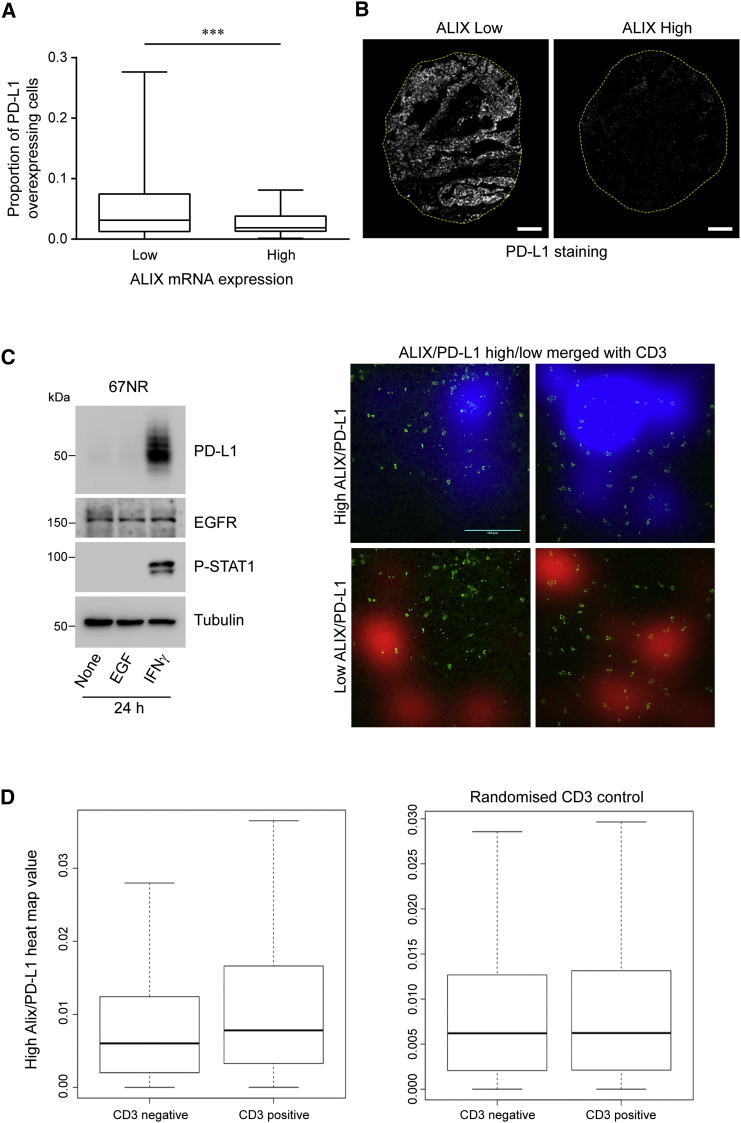
In Vivo Relationship between ALIX and PD-L1 Expression and Its Association with Immune Cell Infiltrate(A) Boxplot of PD-L1 protein expression according to “low” (n = 95) or “high” (n = 94) ALIX mRNA expression, where “low” and “high” indicate less than and greater than the median value, respectively (∗∗∗p < 0.001, Mann-Whitney U, two-tailed test).(B) Fluorescence images of PD-L1 immunostaining of representative breast cancer tissue specimens associated with low (left) and high (right) ALIX mRNA expression (dotted line indicates the perimeter of tissue specimen). Scale bars, 100 μm.(C) Western blot showing IFNγ-dependent induction of PD-L1 in 67NR cells. Spatial analysis of ALIX, PD-L1, and CD3 expression in tissue sections processed for analysis by immunofluorescence. Comparison of CD3+ cell position with heatmaps of high and low ALIX:PD-L1 expression ratios in 67NR tumors. Representative composite images of CD3 channel (green) with ALIX:PD-L1 ratio heatmaps (red and blue). Heatmaps were generated by applying a 2D Gaussian image blur to a thresholded ALIX:PD-L1 ratio image. Ratio images were thresholded for pixel regions (>1 pixel) where the ratio > 2.0 (high ratio) or < 0.5 (low ratio) after ALIX intensity values were normalized to achieve a baseline ratio of 1.0. Pixels where the ALIX:PD-L1 ratio was <0.5 (low ratio) are more excluded for CD3+ T cell infiltration. Scale bar, 100 μm.(D) Quantification of data from (C). Left panel: in 67NR tumors, the presence of CD3 correlates with a higher heatmap value (CD3+ mean = 0.0115, SEM = 0.0002; CD3− mean = 0.00884, SEM = 0.00005, Kolmogorov-Smirnov test, p < 0.001). Right panel: representative baseline correlation by randomizing the position of CD3 value (CD3+ mean = 0.00914, SEM = 0.0002; CD3− mean = 0.00903, SEM = 0.00006, Kolmogorov-Smirnov test, p = 0.6). A total of 12 images were analyzed. Boxplots represent 30,000 20 × 20 pixel regions.